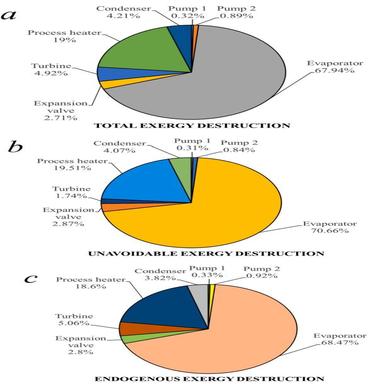
Exergy destruction rate of the ORC-CHP components in total exergydestruction (a) unavoidable destruction rate in total unavoidable part (b) and endogenous destruction rate in total endogenous part (c) (R141b).